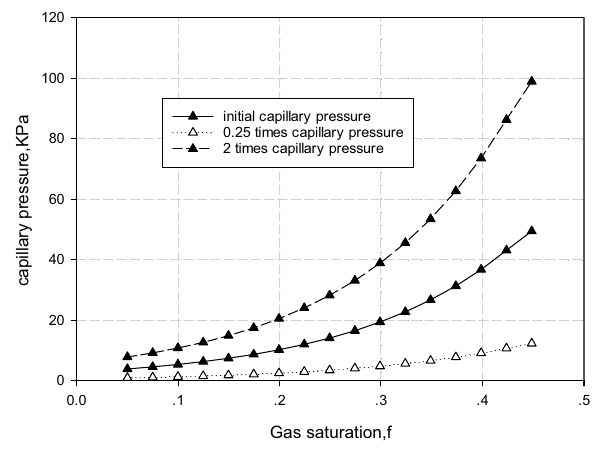
Fig. 4 Cumulative production match curves in CO